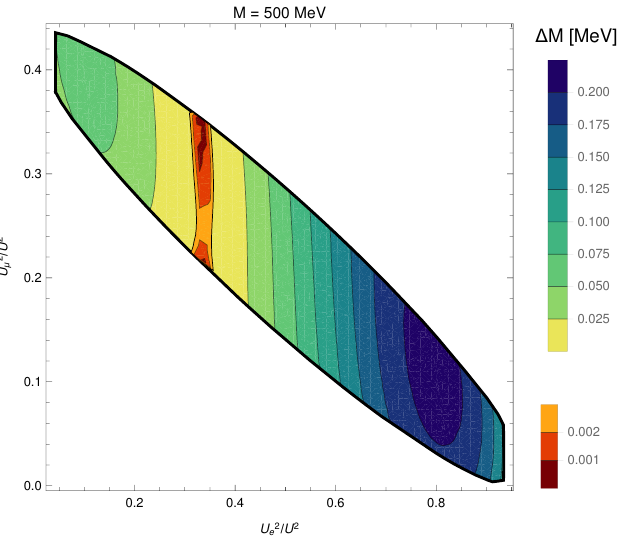
Figure 11 . Maximally allowed mass splitting (cid:1) M for given U 2 be generated by leptogenesis. This is an example plot shown in the U 2 hierarchy with a (cid:12)xed Im ! = 2 (corresponding to U 2 = 5 : 38 (cid:2) 10 (cid:0) 9 ) and a mass (cid:22) M = 0 : 5 GeV. The thick black lines enclose the region within which neutrino oscillation data can be explained, cf. the bottom panel of (cid:12)gure 1. U 2